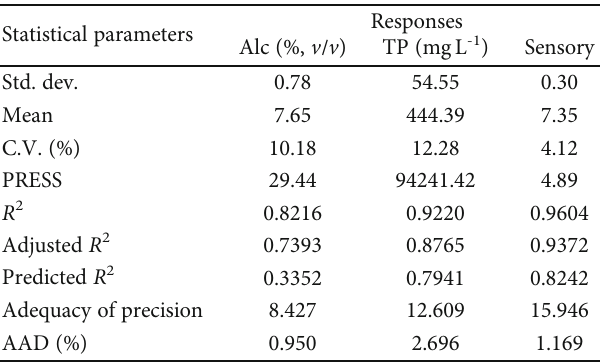
Table 6: Experimental data analysis for all predictive response